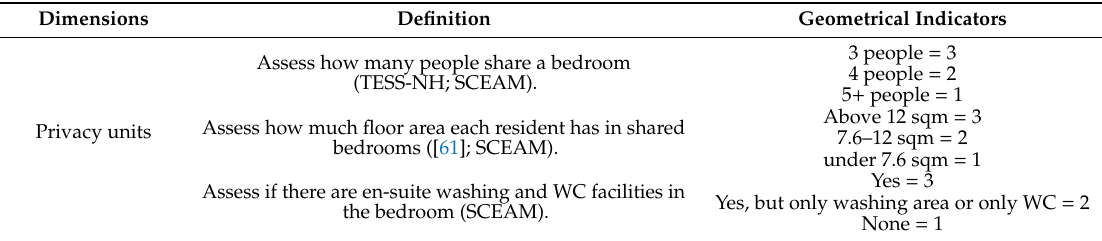
Table 2. Design dimensions and indicators for privacy in shared